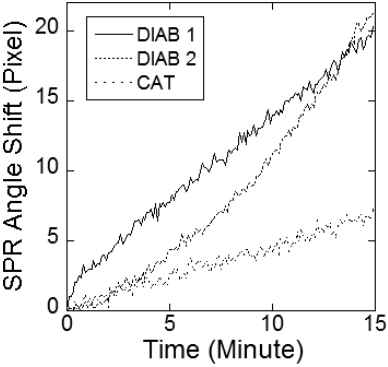
Fig. 5. Comparison of SPR angle shifts of the aqueous humor samples from diabetes patient and cataract